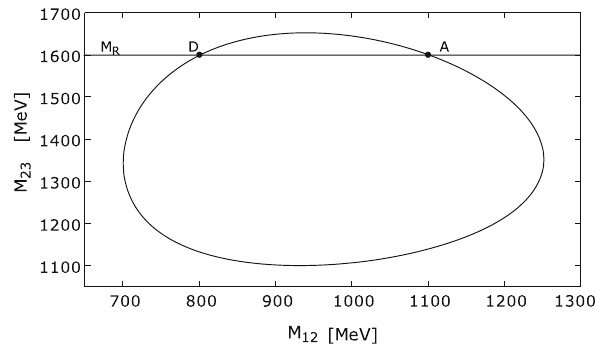
13000.00.20.40.60.81.01.21.4